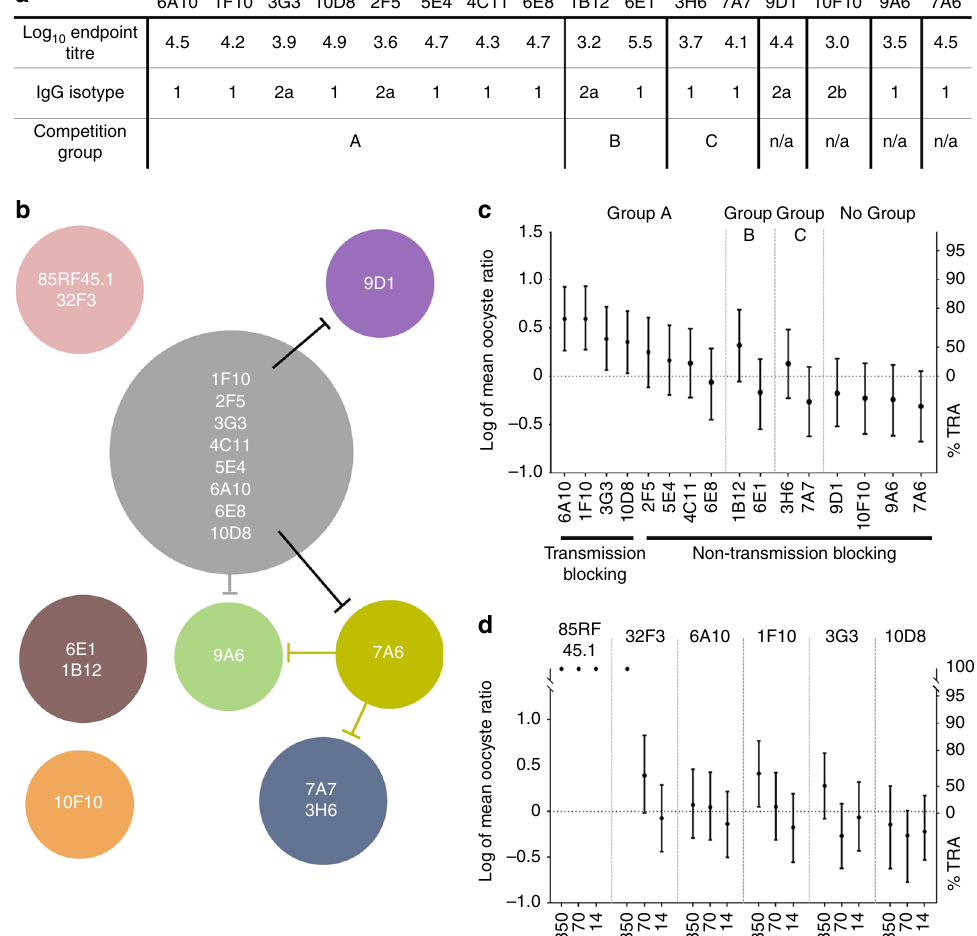
Fig. 2 Full-length Pfs48/45 induces functional polyclonal and monoclonal antibodies in mice. a . A panel of Pfs48/45-speci fi c mAbs was raised from splenocytes of mice immunised with full-length Pfs48/45. End point titres were determined by Pfs48/45 end point ELISA. The IgG isotypes of the individual mAbs are indicated. The mAbs were grouped by cross-competition ELISA. b Schematic depiction of competition groups in the mAb panel and 85RF45.1 and 32F3. Lines indicate cross-competition between whole groups or individual mAbs and other competition groups. c Transmission-reducing activity of the anti-Pfs48/45 mAb panel at a concentration of 375 µ g/ml was determined relative to normal mouse antibody. Data points show %TRA calculated from the oocyst counts in 20 mosquito midguts for non-transmission-blocking mAbs and 40 mosquito midguts from two independent feeds for transmission-blocking mAbs, error bars show 95% CI. d Transmission-reducing activity of selected anti-Pfs48/45 mAbs was determined relative to normal mouse IgG at 350, 70 and 14 µ g/ml. Data points show transmission-reducing activity calculated from the oocyst counts in 20 mosquito midguts, error bars show 95% tested concentration of 350 µg/ml (%TRA = 61.0%; 95% CI = 11.0 – 82.8%; p = 0.032). Similarly, 32F3 showed signi fi cant TRA only at 350 µg/ml (%TRA = 99.8%; 95% CI = 98.9 – 100%; p =